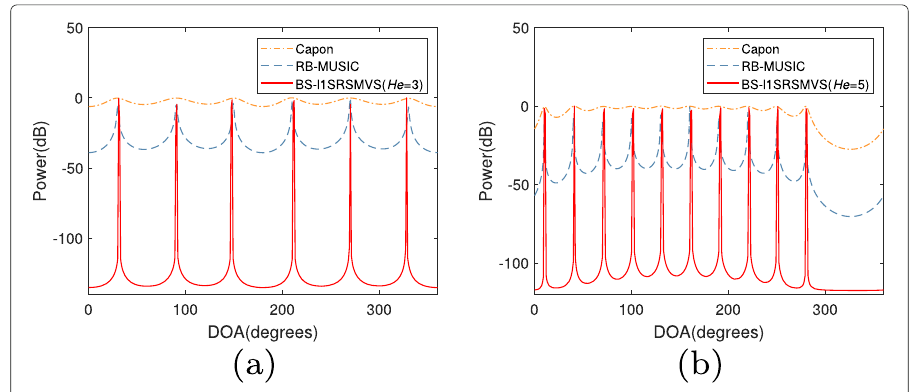
Fig. 3 Spatial spectra for Capon beamformer , RB-MUSIC and BS- (cid:2) 1 -SRSMVS. a M =7, r /λ =0.5, N =1000, SNR=0, H e =3, DOAs=(30 ◦ , 90 ◦ , 150 ◦ , 210 ◦ , 270 ◦ , 330 ◦ ). b M =11, r /λ =0.5, N =2000, SNR=20, H e =5, DOAs=(10 ◦ , 40 ◦ , 70 ◦ , 100 ◦ , 130 ◦ , 160 ◦ , 190 ◦ , 220 ◦ , 250 ◦ , 280 ◦